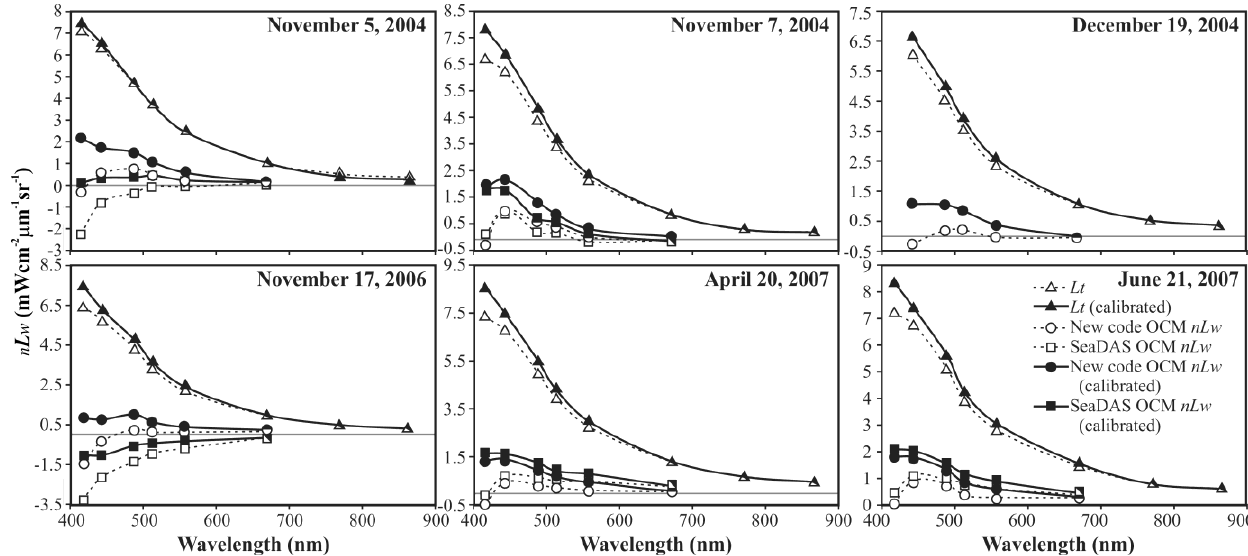
Figure 8. Comparison of new code and SeaDAS computed OCM and SeaWiFS